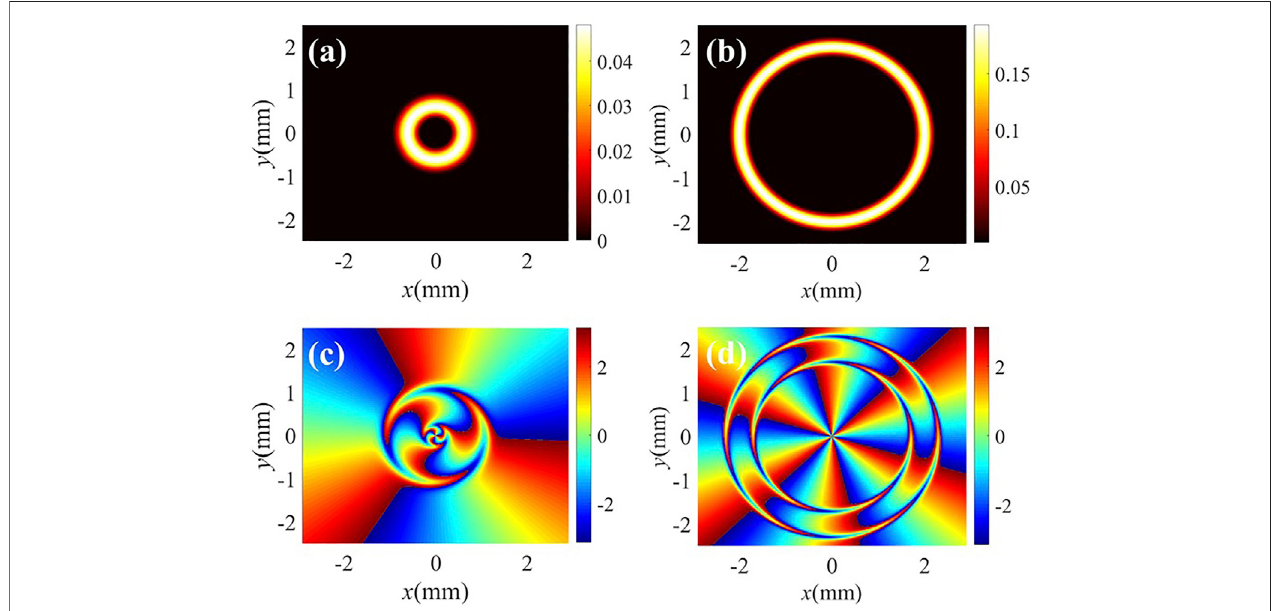
FIGURE8|(A,B) Intensityand (C,D) phasepro fi lesoftheFWM fi eldfordifferentbeams. (A,C) LGbeamwith p =0, l =3,and w LG =0.5mm; (B,D) POVbeamwith l = 6. Other parameters are the same as in Figure 2C